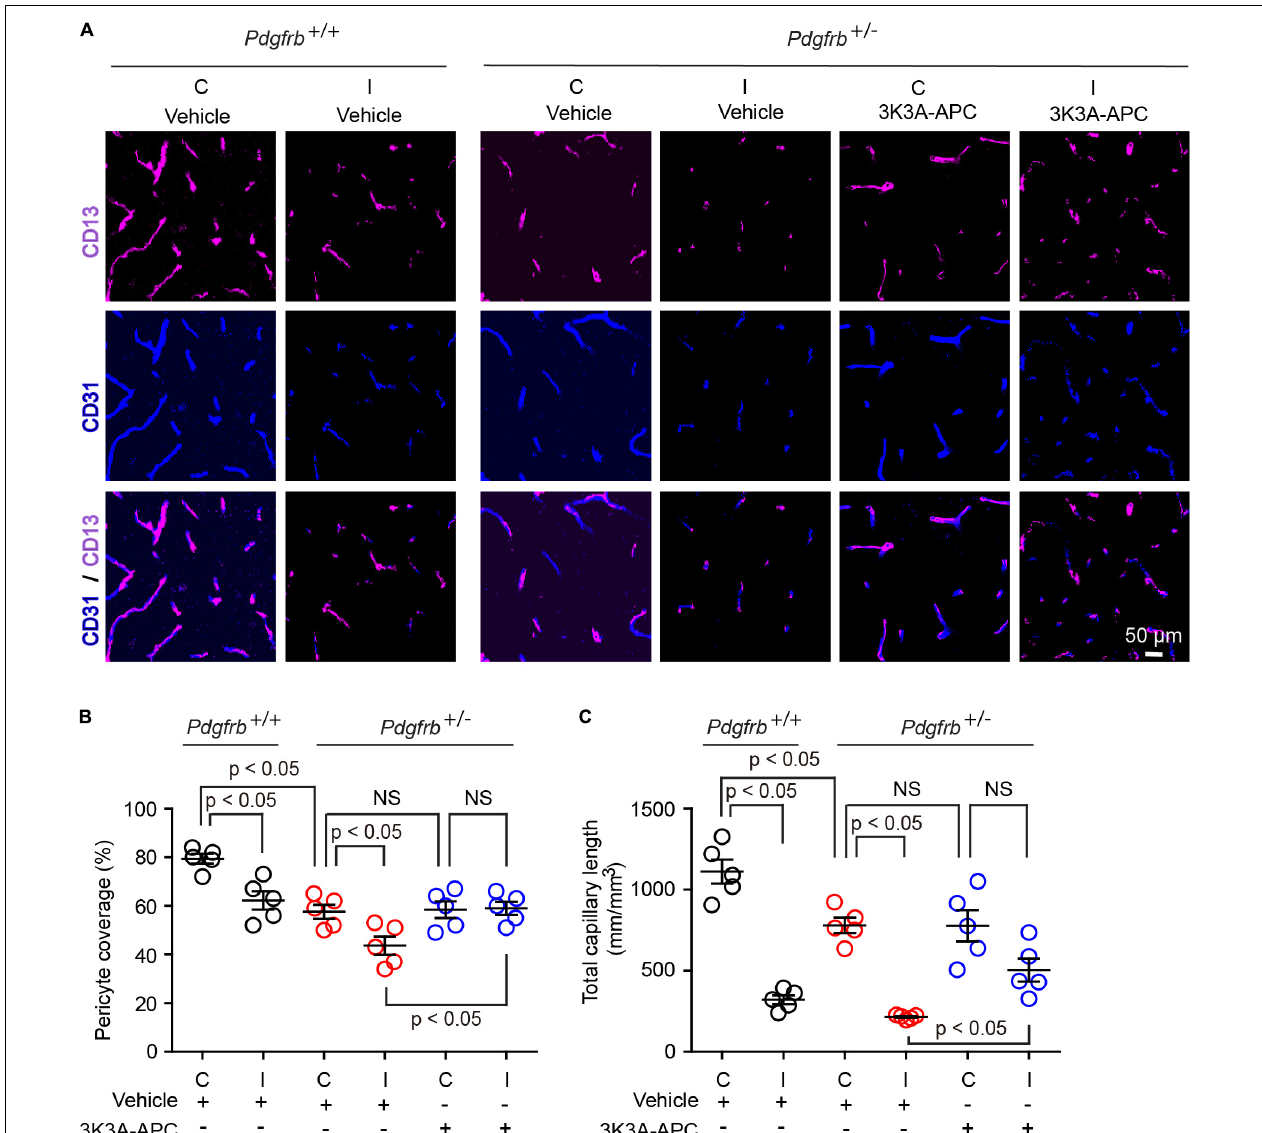
FIGURE 3 | 3K3A-APC alleviates post-ischemic loss of pericyte coverage and capillary microvascular length in pericyte-deficient Pdgfrb + / − mice. (A) Immunostaining for endothelial (CD31) and pericyte (CD13) markers in non-ischemic contralateral cortex (“C”) and ischemic core of the ipsilateral cortex (“I”) 24 h after tMCAo in Pdgfrb + / + mice and Pdgfrb + / − mice treated with vehicle or 3K3A-APC. Quantification of CD13 + -pericyte coverage of CD31 + -endothelial capillary ( < 6 µ m in diameter) profiles (B) and total length of CD31 + -endothelial capillary profiles (C) in non-ischemic contralateral cortex (“C”) and ischemic core of the ipsilateral cortex (“I”) 24 h after tMCAo in Pdgfrb + / + mice and Pdgfrb + / − mice treated with vehicle or 3K3A-APC. In (B,C) , mean ± SEM, n = 5 mice per group. The p -values were calculated by one-way ANOVA followed by Tukey’s multiple comparisons